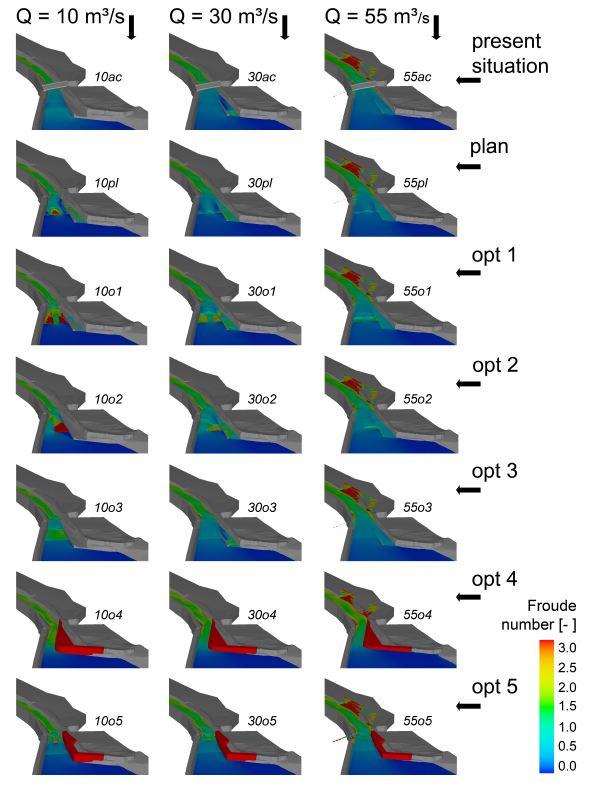
Fig. 6. Results from hydrodynamic numerical modelling for the discharges Q = 10m 3 s − 1 , Q = 30m 3 s − 1 and Q = 55m 3 s − 1 – (steady state) flow conditions and Froude numbers, based on depth- averaged flow velocities, for the present situation and the design layouts (Fig. 4); the geometry within the images is displayed with each of the stereolitography